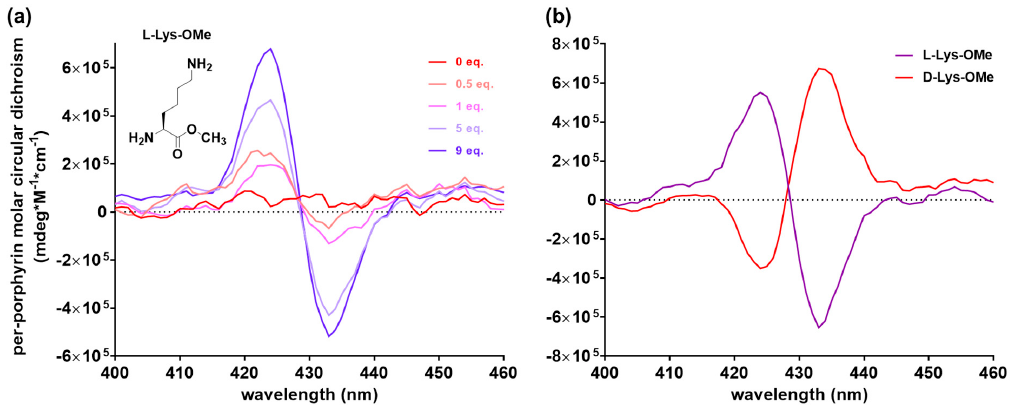
Figure 2. Circular dichroism (CD) spectra of 1 (1 μ M) in CH 2 Cl 2 at 20 °C upon the addition of L - or D - Lys-OMe. ( a ) L -Lys-OMe was added from 0 to 9 equivalents. ( b ) CD spectra of 1 with L - or D -Lys-OMe (17 equivalent each) were